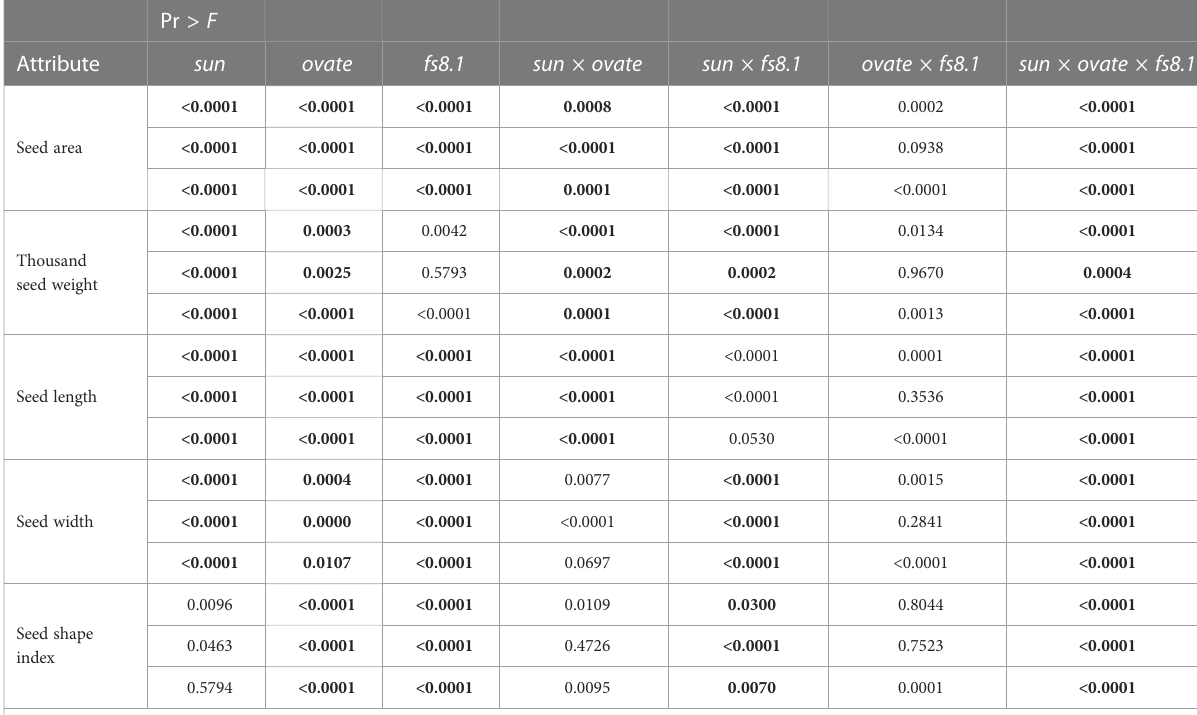
TABLE 2 Effects and interactions of sun , ovate and fs8.1 on the size and shape attributes of mature seeds. Pr >